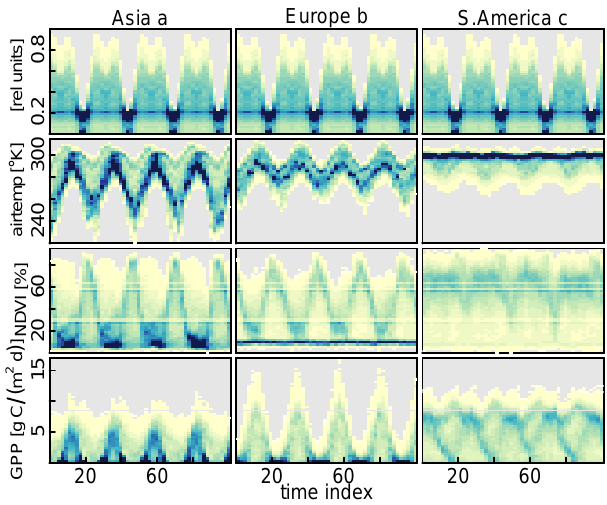
Fig. 4. Visualisation of the temporal patterns in the test datasets. All time series are plotted, and the colour code shows the densities of points per pixel (yellow=1,